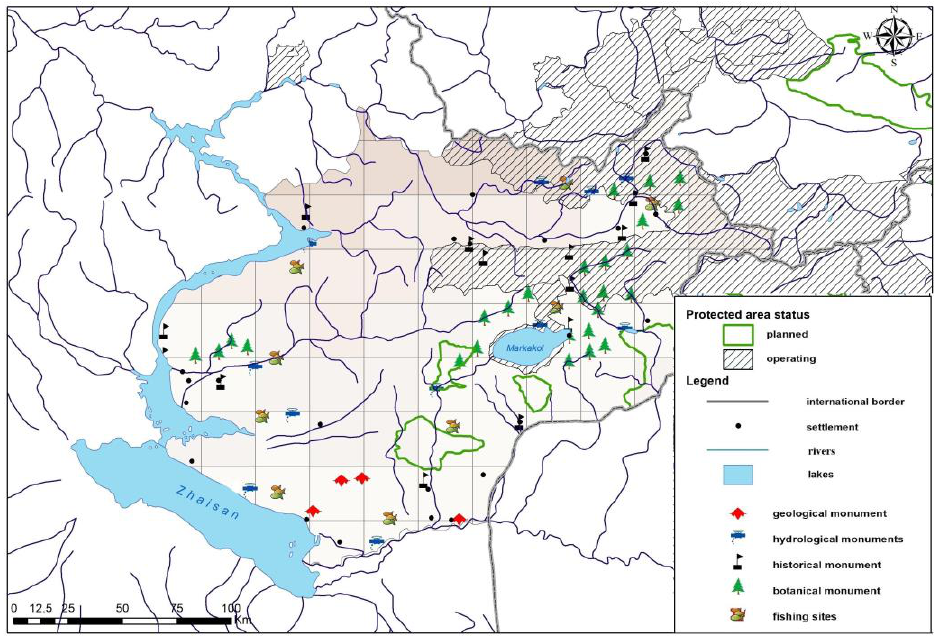
Figure 2. Map of the main natural and cultural sites, and the present recreation places integrated in the geographical OTU system on the territory of eastern Kazakhstan/the Southern Altai area.